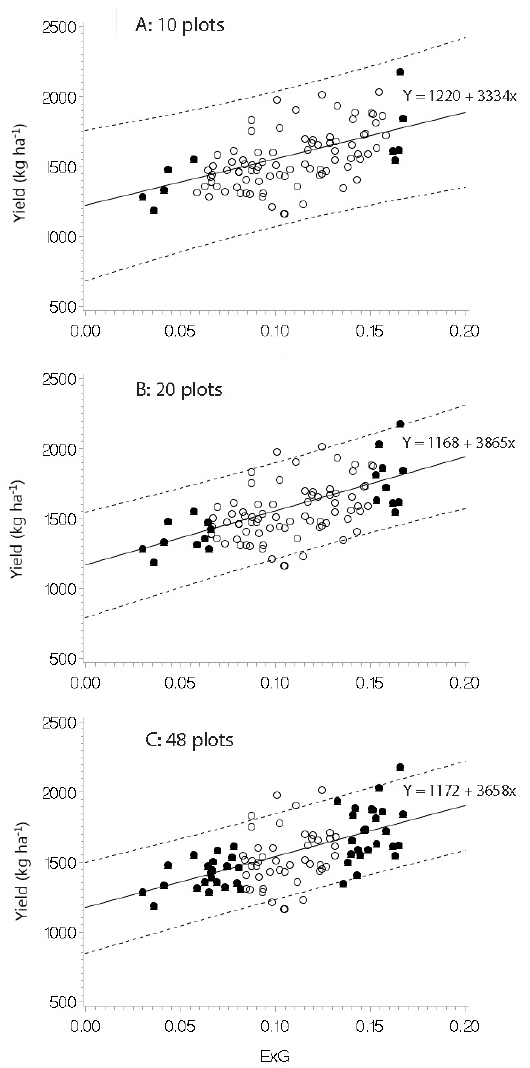
Figure 3. Linear regression models (solid line) with prediction intervals (dotted lines) for specific VI values based on an increasing number of plots in 2018. The model in A is based on 10 plots, B is based on 20 plots and C is based on 24 plots. Plots used in regression analyzes are denoted with dots and validation plots are denoted with open circles. The selection of training data was based on extreme ExG